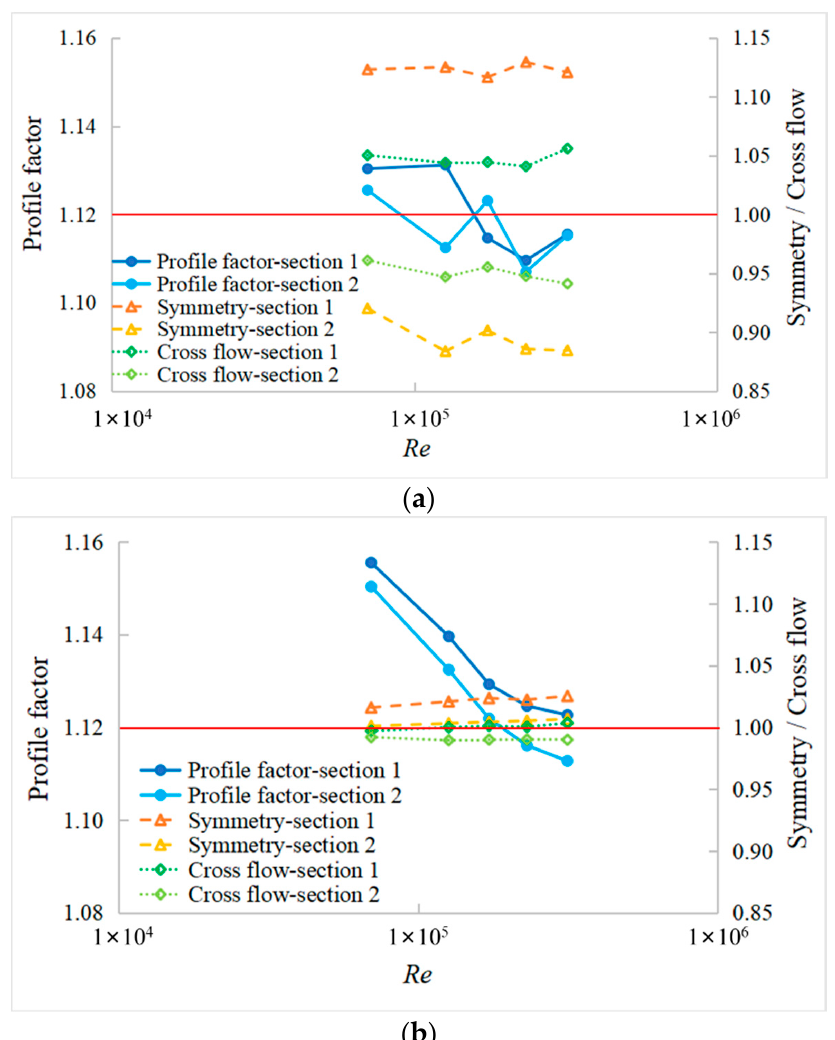
Figure 8. The characteristic parameters of flow distribution in different sections. ( a ) Without flow conditioner (FC), ( b ) With FC.